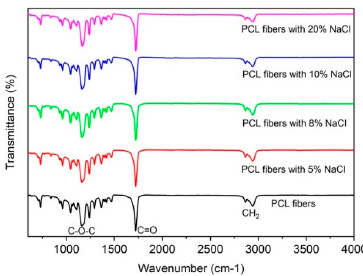
Figure 4. The XRD patterns of the PCL fiber and the PCL fiber with NaCl additive.